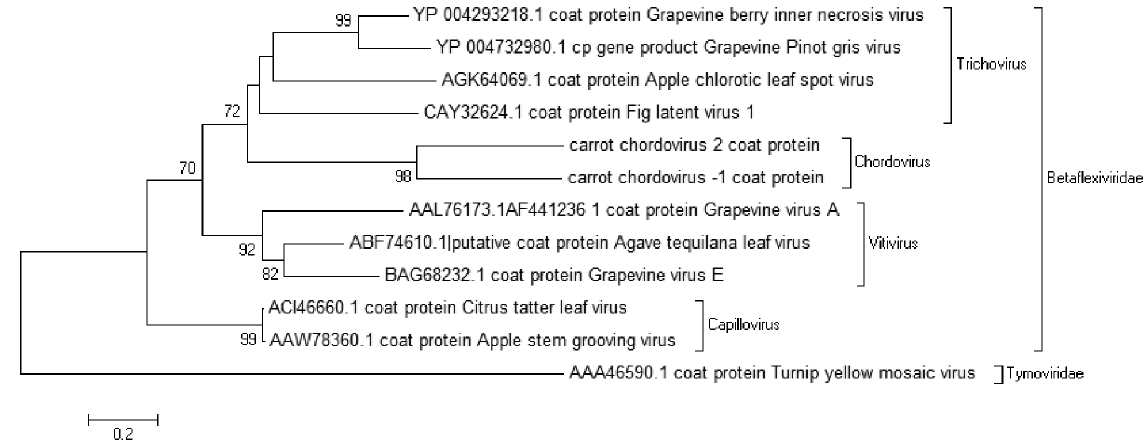
Figure 6. Bootstrapped neighbour joining tree of coat proteins from viruses within the family Betaflexiviridae constructed with MEGA5 using 500 replicates.